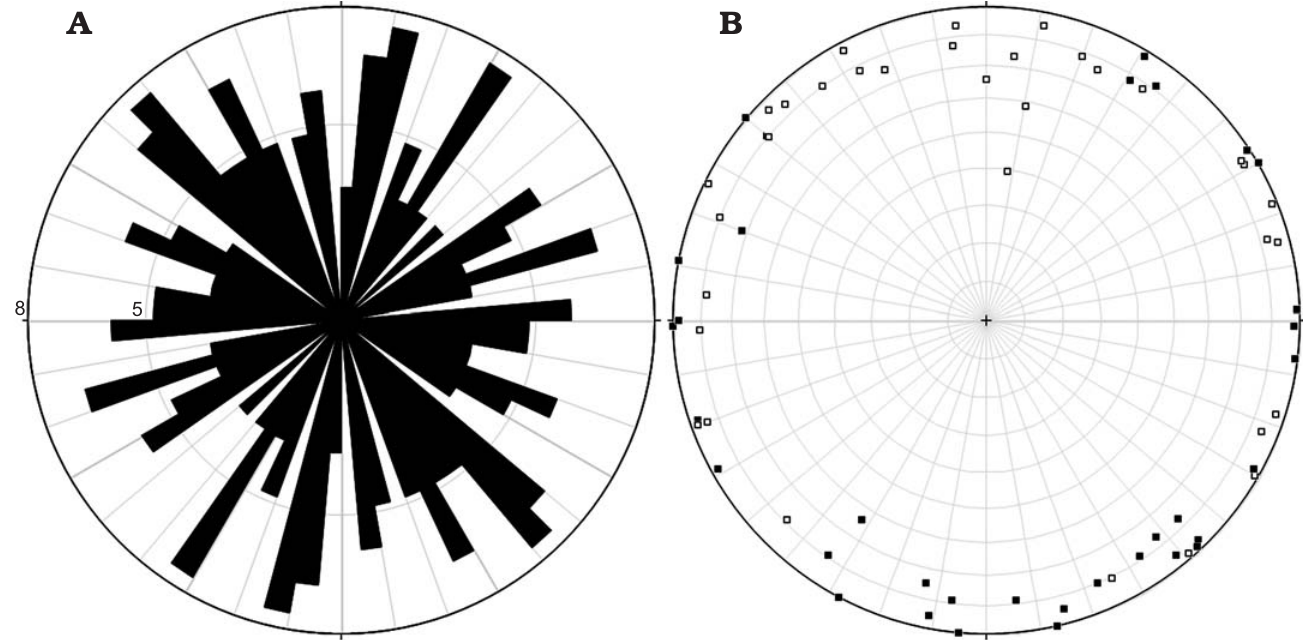
Fig. 8. Orientation of the 70 dacryoconarids in the sample. A . Rose diagram showing the lineations of the dacryoconarids (numbers 5 and 8 refer to dacryo- conarid counts; note that both the tip and aperture where counted of each object resulting in double counts). B . Rose diagram showing dacryoconarids whose apices are higher (open rectangles) and lower (closed rectangles) positioned than their corresponding open ends in relation to an imagined